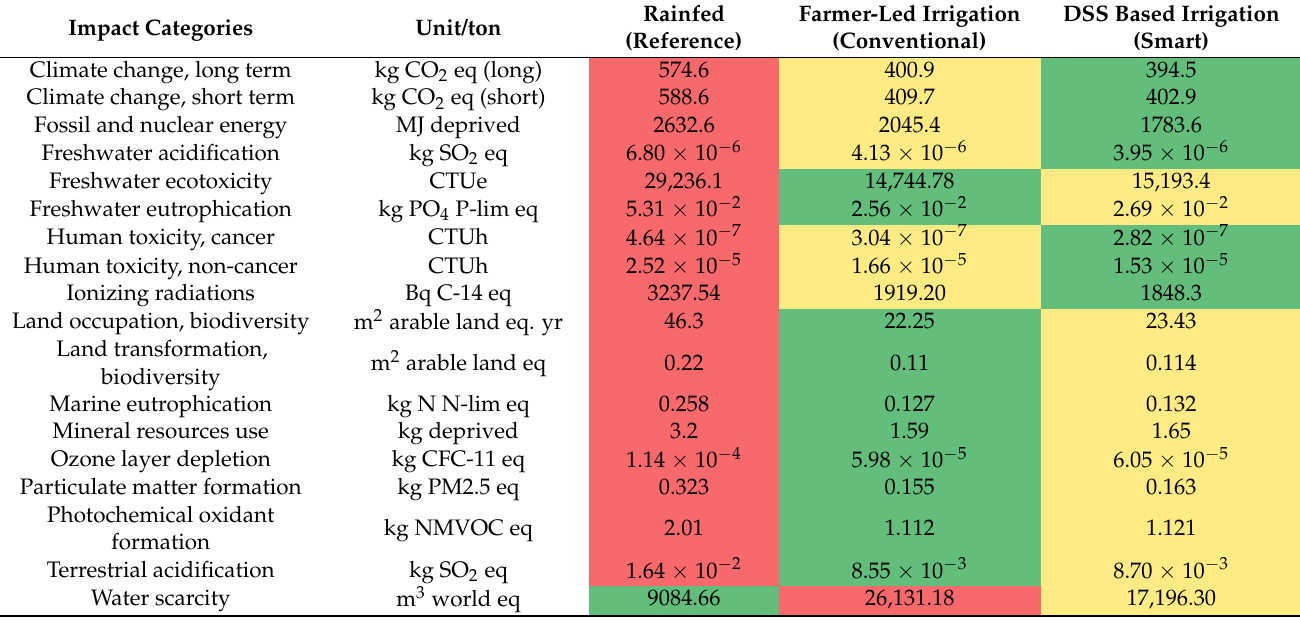
Table 4. LCA-based metrics of 1 ton of olive cultivation in the plain of Arta under different management strategies (graded color scale: green = lowest impact, orange = midpoint, red = highest